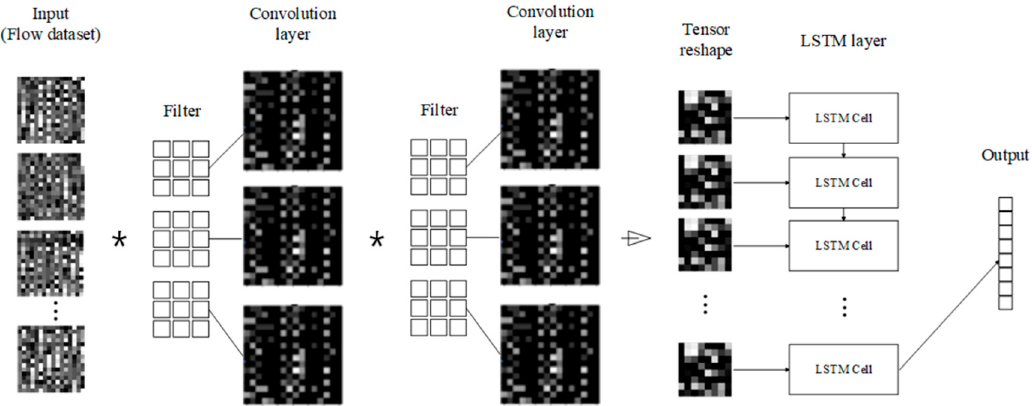
Figure 4. The convolutional neural network (CNN) and LSTM combination learning model architecture. It consists of two convolution layers, reshaping process, and single-layer LSTM.